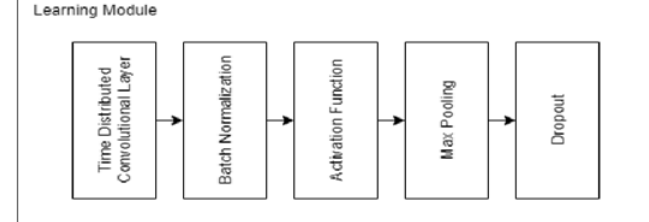
Figure 4. Learning